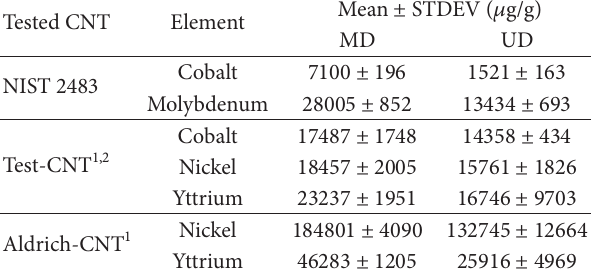
Table 1: Metal concentrations ( > 0.5%) of NIST 2483, Test-CNT, and Aldrich-CNT obtained with both microwave digestion (MD) and ultrasonic digestion (UD) methods. The results are presented as mean ( 𝜇 g/g) and standard deviation of five independent determina- tions. Certified values for Co and Mo in NIST 2483-CNT SRM and methods LODs are presented in Table 3.